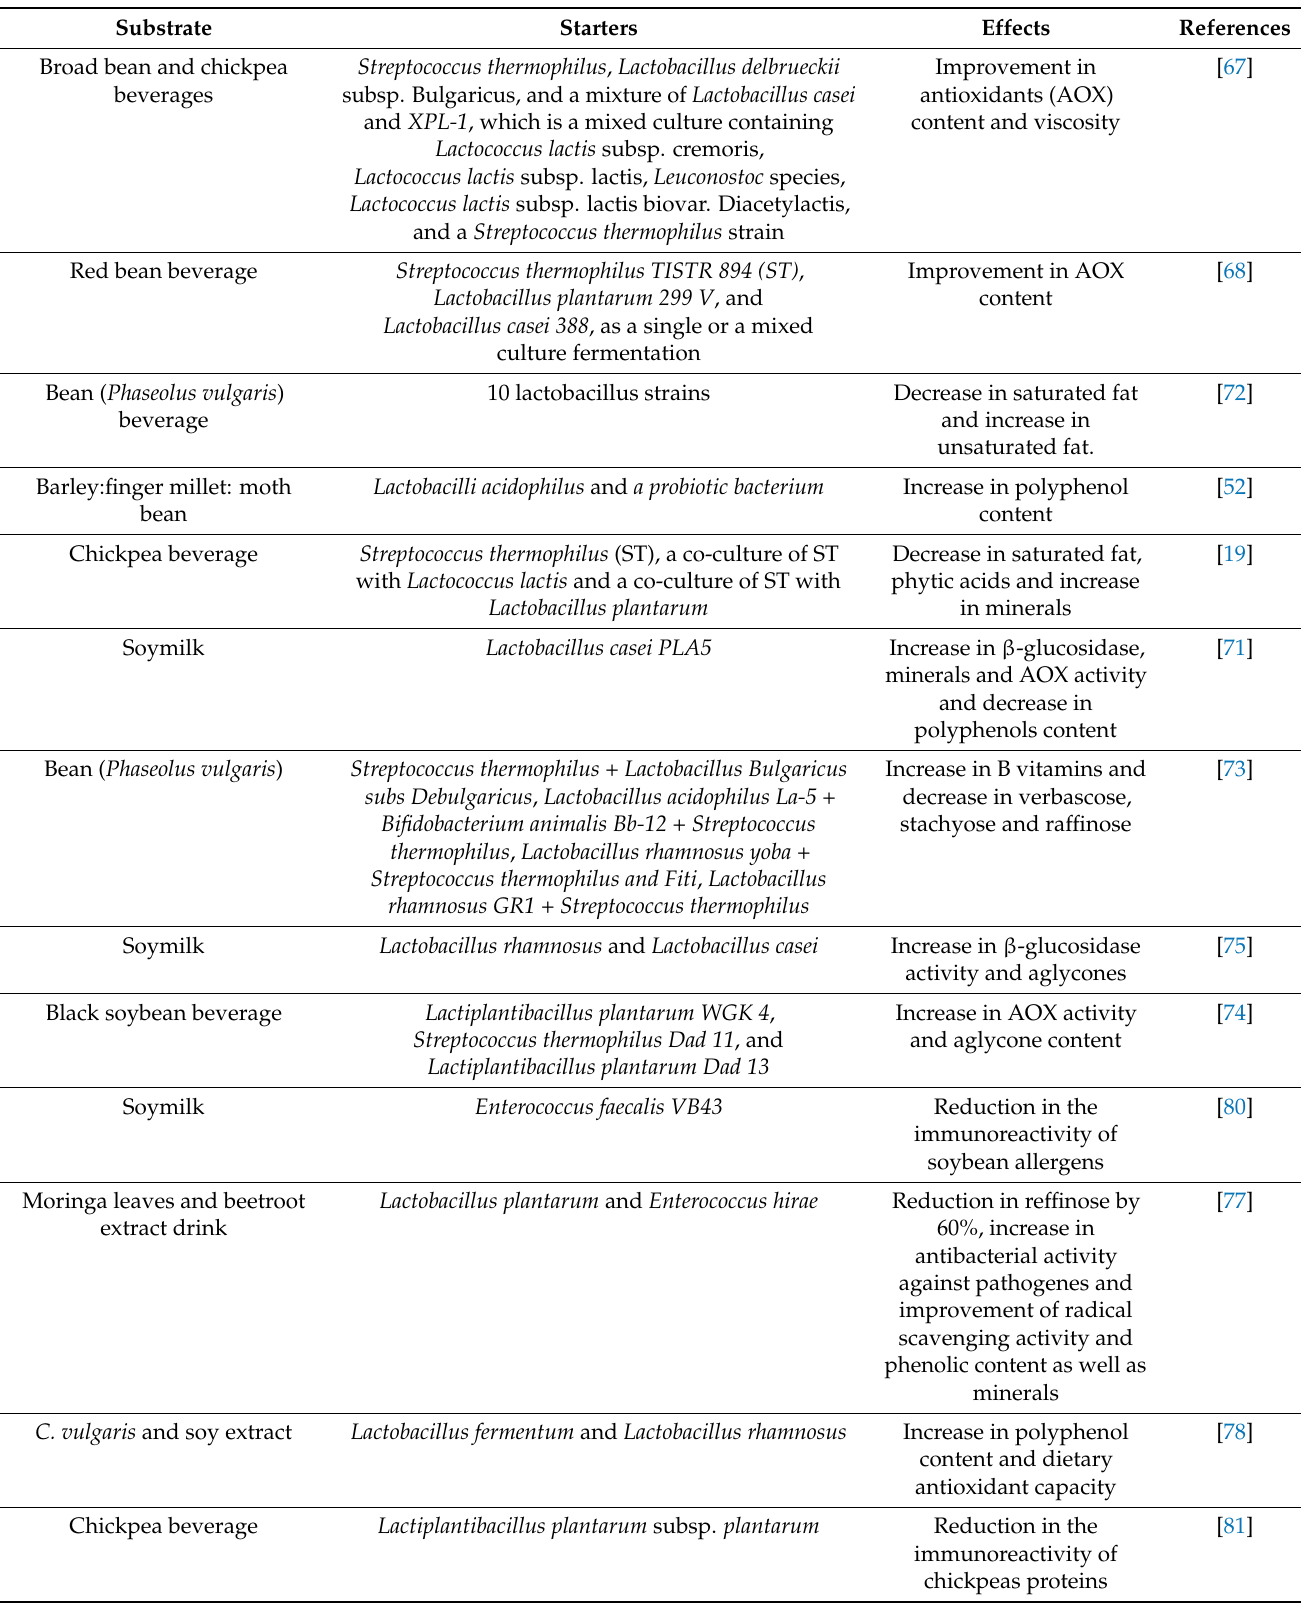
Table 3. Impact of fermentation on the quality of plant-based